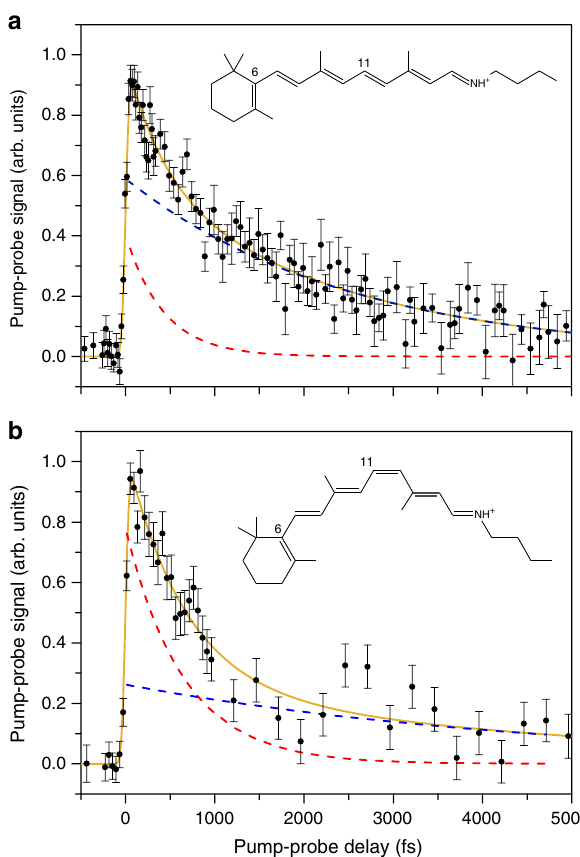
Fig. 6 Pump-probe signal for all- trans and 11- cis retinal protonated Schiff- base (RPSB) samples in the gas phase. Pump-probe signal for all- trans (top) and 11- cis (bottom) samples obtained with 600nm pump and 800 nm probe at room temperature. The full curve is from a fi t with two exponential functions folded with the 80 fs cross-correlation in the experiment. The dashed lines represent the two decay components in the fi t 424 ± 121 fs and 2.5 ± 0.3 ps for all- trans and 650 ± 160 fs and 4.7 ± 3 ps for 11- cis RPSB. All error bars presented are one standard deviation